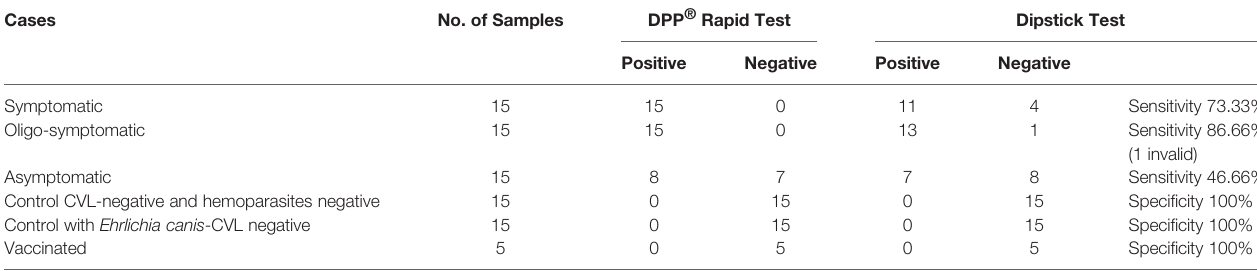
TABLE 2 | Performance of dipstick test at Universidade Federal da Grande Dourados (UFGD), Brazil. Cases